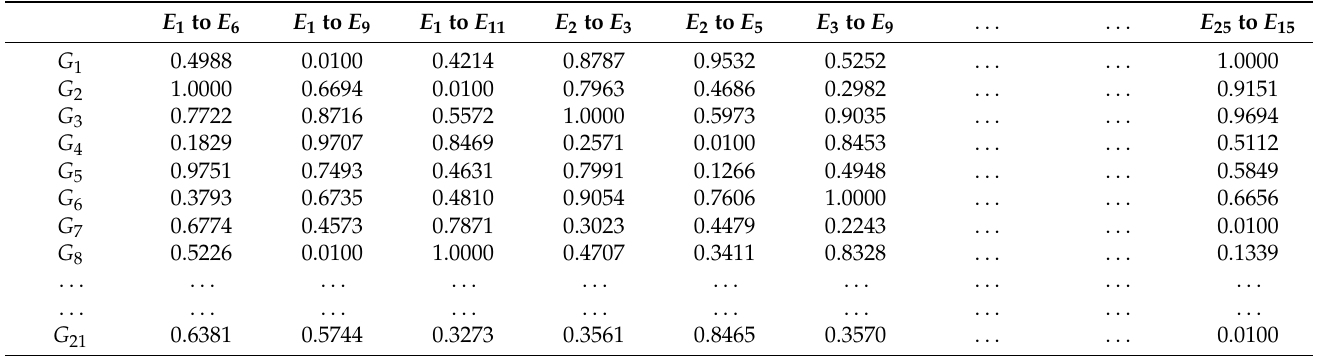
Table 2. 50 pieces of collaborative data from 25 collaborative enterprises after normalization.